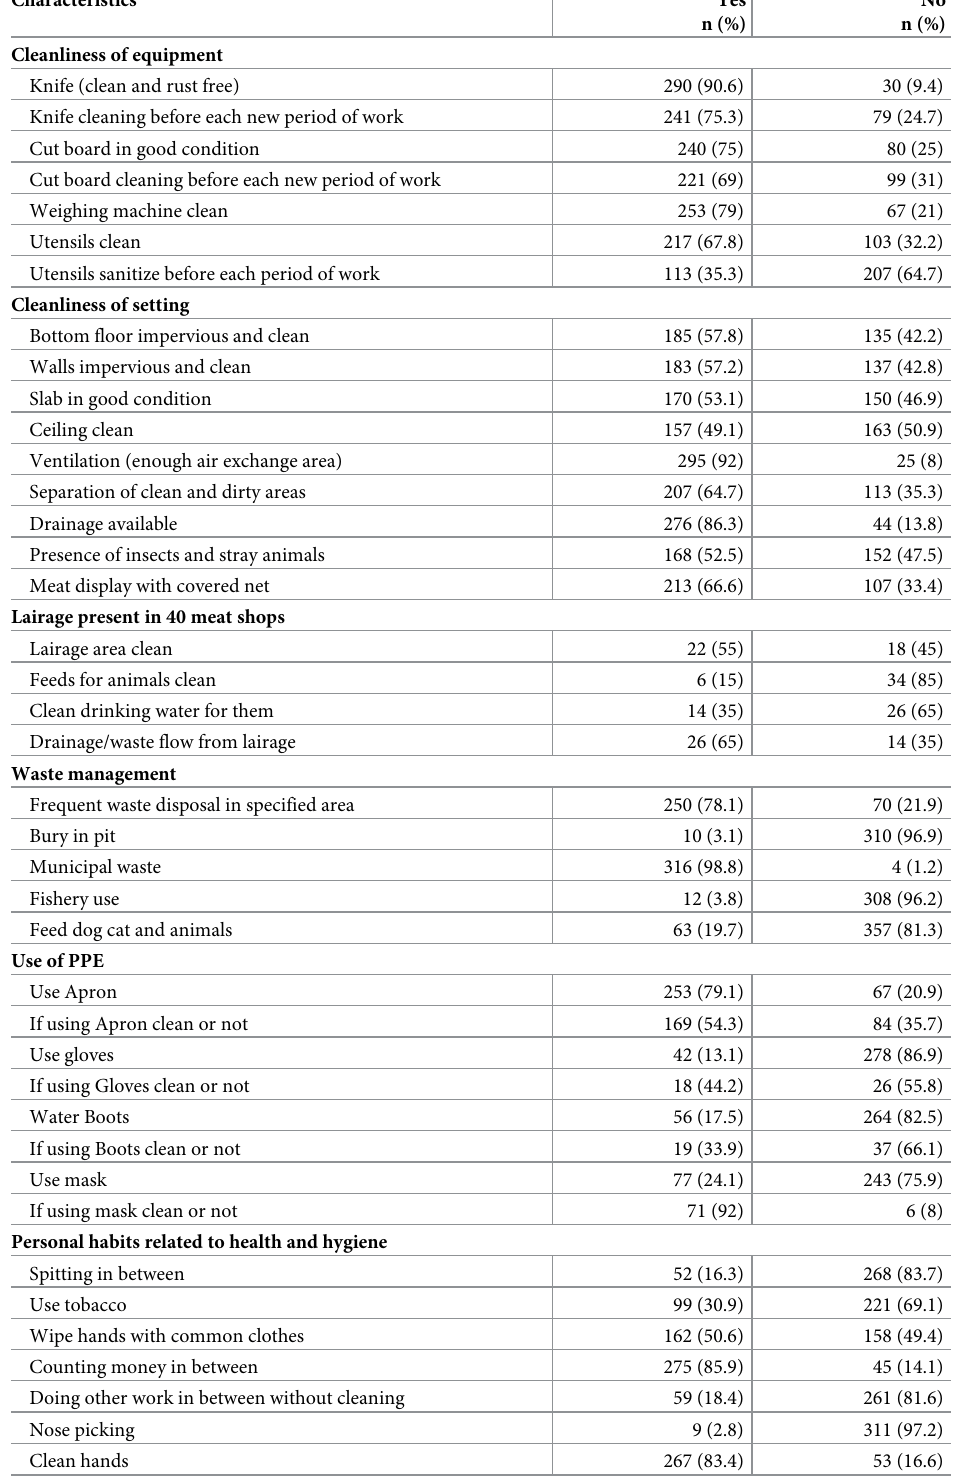
Table 2. Observations on equipment, setting and waste management practices of